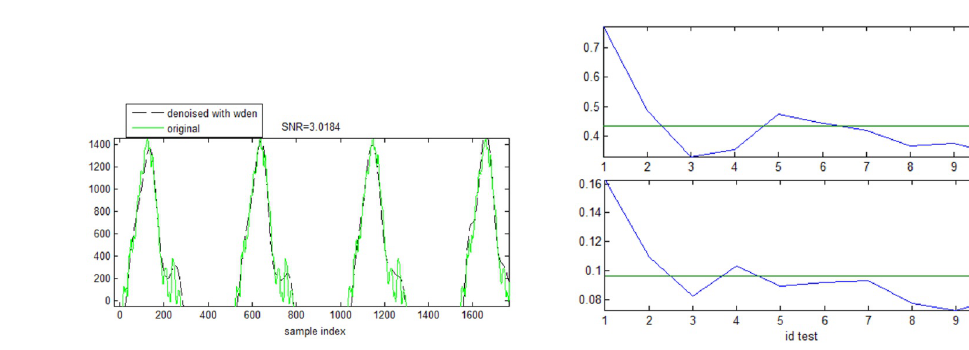
Figure 8. Zoom from Fig. 7. Figure 9. Steady signals, denoising with wden. Top MAD , bottom – RMSD.